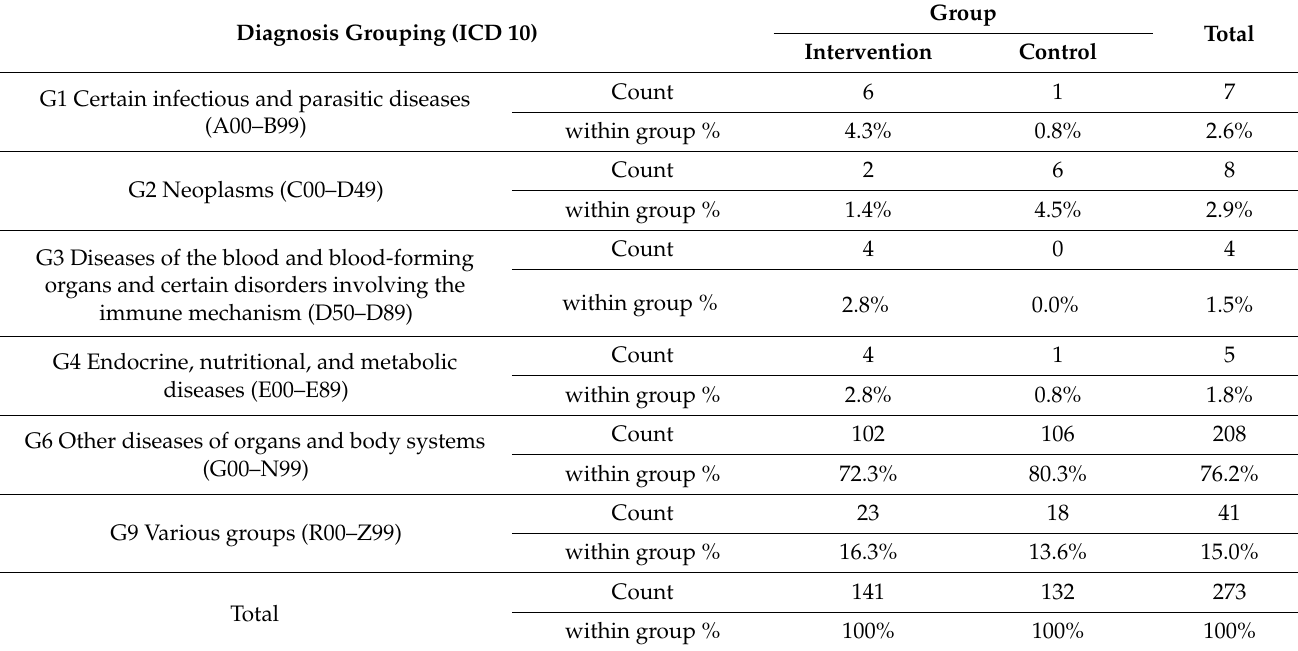
Table 2. Distribution of diagnoses at admission